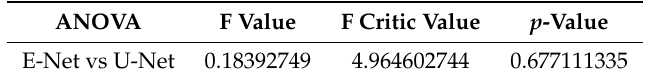
Table 3. ANOVA on the dice similarity coe ffi cient (DSC) showed no statistical di ff erences between segmentation